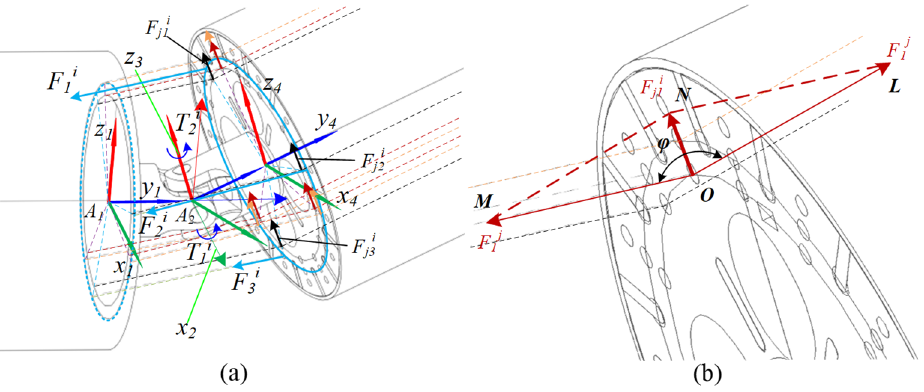
Figure 7. Force analysis of any joint in any posture (the i -th joint was taken as an example). ( a ) i -joint coordinate system and cable forces. ( b ) Local enlargement of F j 1 Using coordinate transformation, the (cid:2171), (cid:2168), (cid:2170), (cid:2169) points are respectively transformed into the coordinate system ((cid:1876) (cid:2870) , (cid:1877) (cid:2870) , (cid:1878) (cid:2870) ) and ((cid:1876) (cid:2871) , (cid:1877) (cid:2871) , (cid:1878) (cid:2871) ) , with (cid:2157) (cid:2779) as the coordinate origin. In the (cid:2157) (cid:2779) ((cid:1876) (cid:2870) , (cid:1877) (cid:2870) , (cid:1878) (cid:2870) ) coordinate system, the coordinates of point (cid:2171)((cid:1876) (cid:3016)(cid:2870) , (cid:1877) (cid:3016)(cid:2870) , (cid:1878) (cid:3016)(cid:2870) ) , as well as the size and direction of the vector ( (cid:2162) (cid:2778)(cid:2192) ) are known. The coordinates of (cid:2168)((cid:1876) (cid:3013)(cid:2870) , (cid:1877) (cid:3013)(cid:2870) , (cid:1878) (cid:3013)(cid:2870) ) and (cid:2169)((cid:1876) (cid:3014)(cid:2870) , (cid:1877) (cid:3014)(cid:2870) , (cid:1878) (cid:3014)(cid:2870) ) can be obtained using matrix transformation and the distance for- mula between two points. From the geometric properties of the parallelogram in space, the coordinates of (cid:2170)((cid:1876) (cid:3015)(cid:2870) , (cid:1877) (cid:3015)(cid:2870) , (cid:1878) (cid:3015)(cid:2870) ) can be obtained as follows: